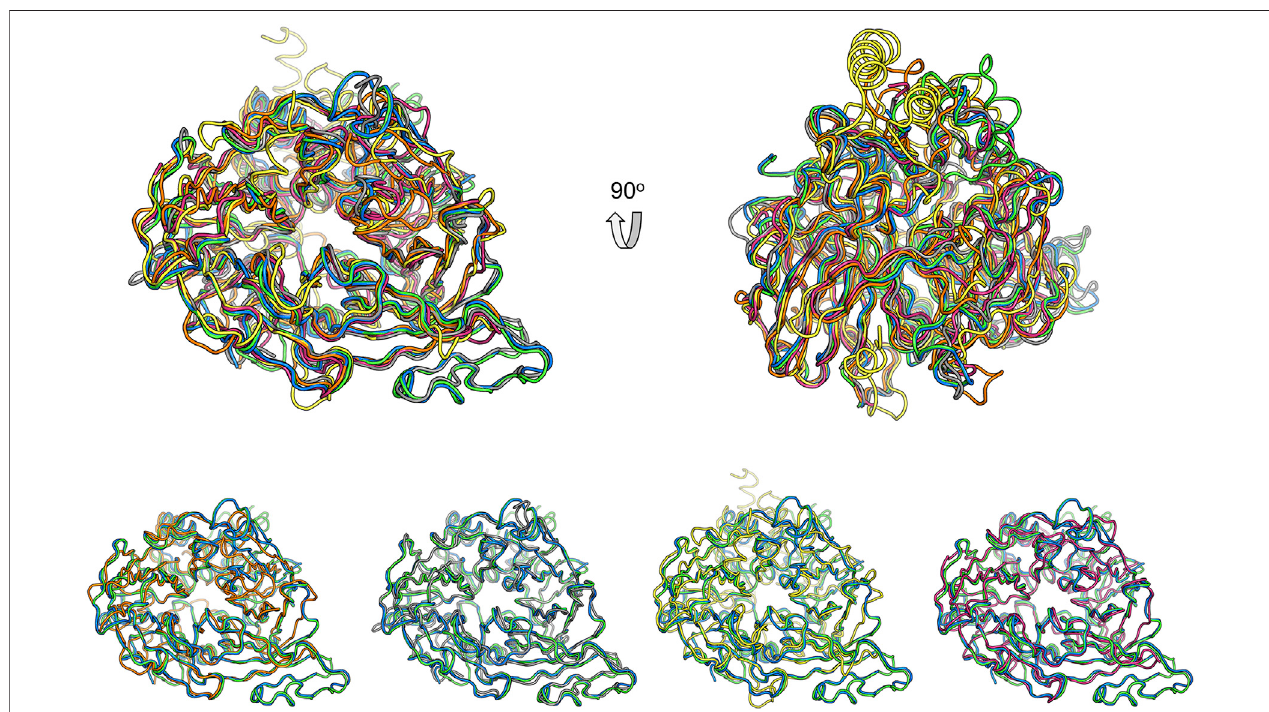
FIGURE 8 | Comparison of BCMO-1 and BCMO-2 with ACO, RPE65, VP14, and NdCCD. Superimposed structures are in tube representation. BCMO-1 and BCMO-2areingreenandblue, respectively.ThecoordinatesofACO (orange), RPE65(gray), VP14(yellow), andNdCCD (purple red)arefromPDBentries2BIW, 4RSE, 3NPE, and 6VCF, respectively. Superimposition of BCMO-1 and BCMO-2 with individual CCD protein is shown in the bottom